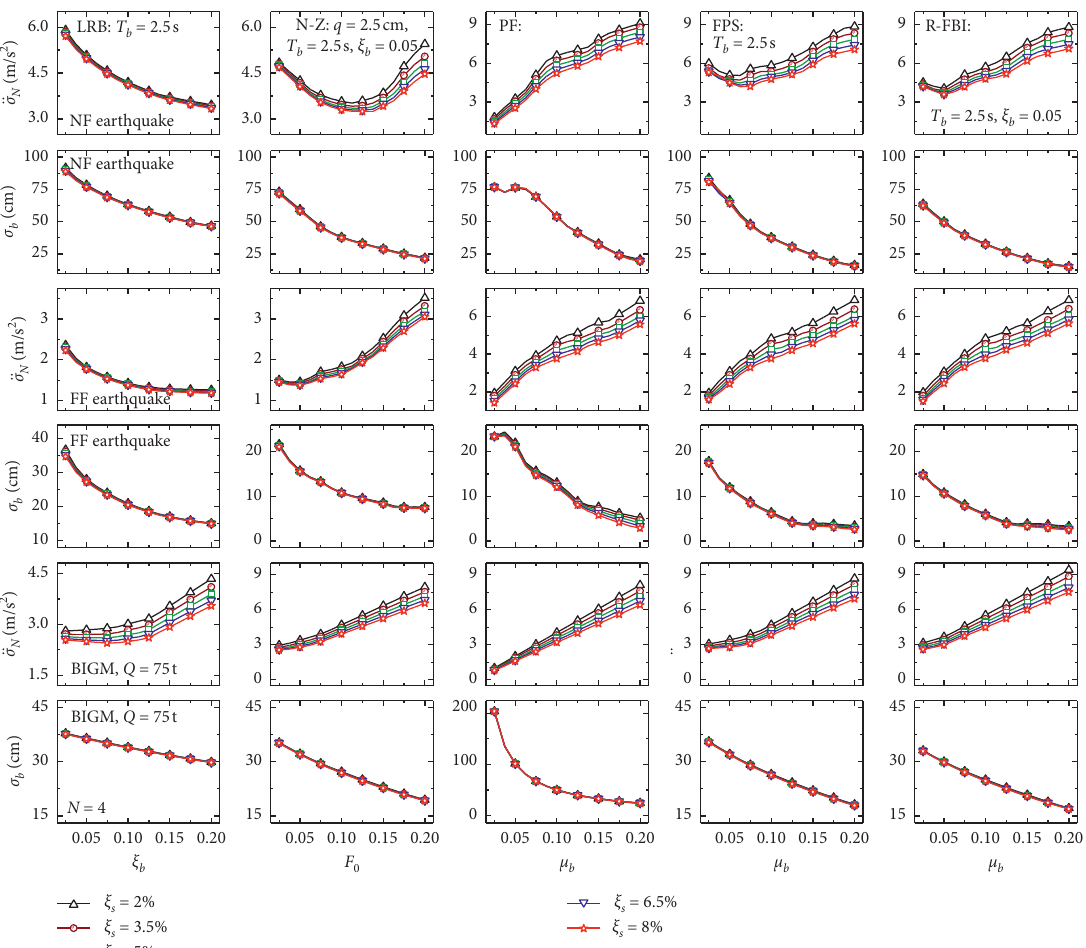
Figure 16: The effect of the superstructure damping on the response of the four-story base-isolated buildings under NF earthquake, FF earthquake, and